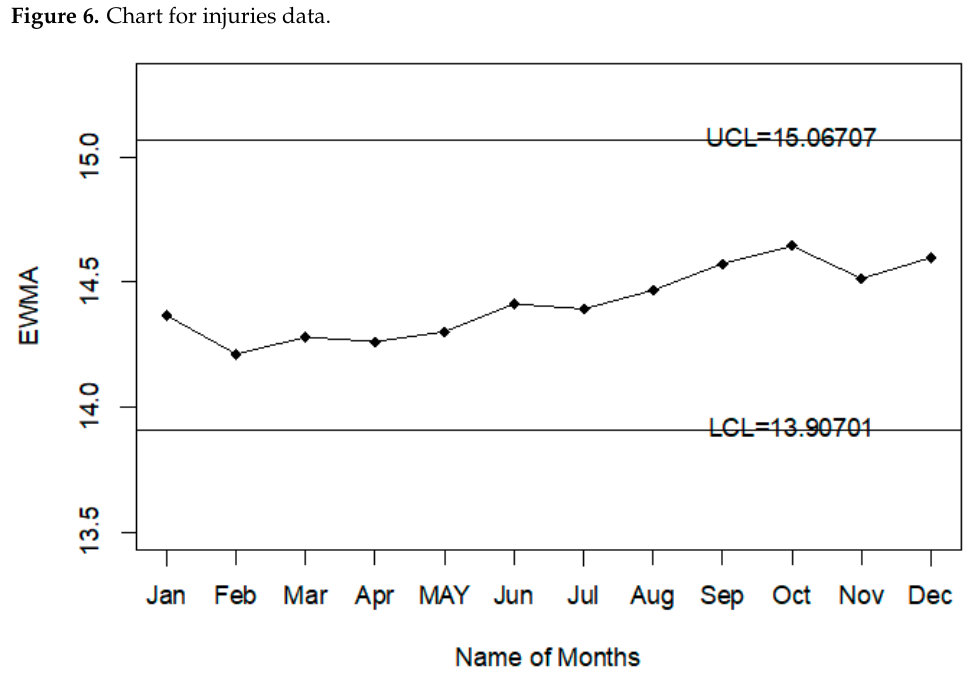
Figure 7. Chart for injuries